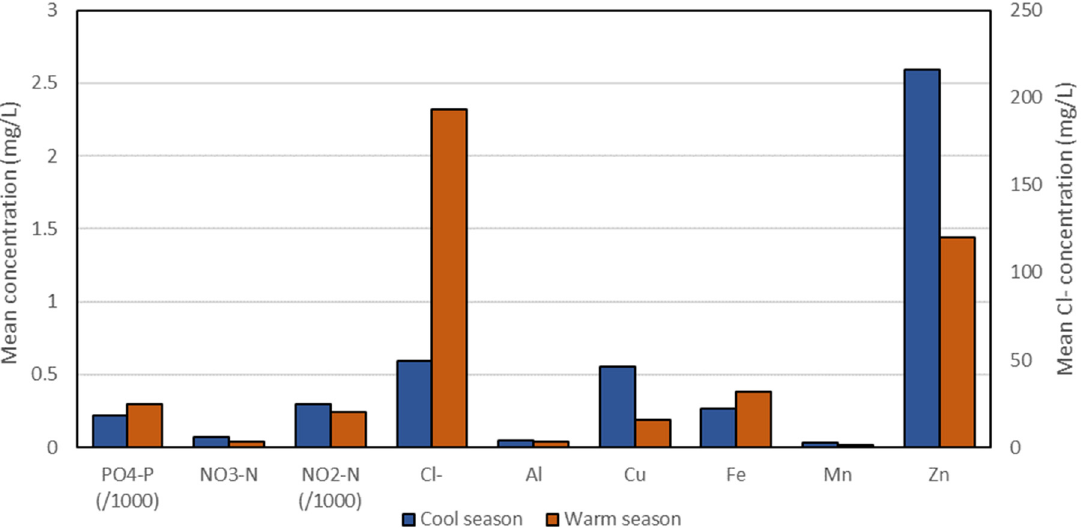
Figure 4. Comparison of dissolved nutrient and metal concentrations in infiltrated water in roadside ditches maintained with warm and cool season grasses on I-29 near Trent, South Dakota, United States.